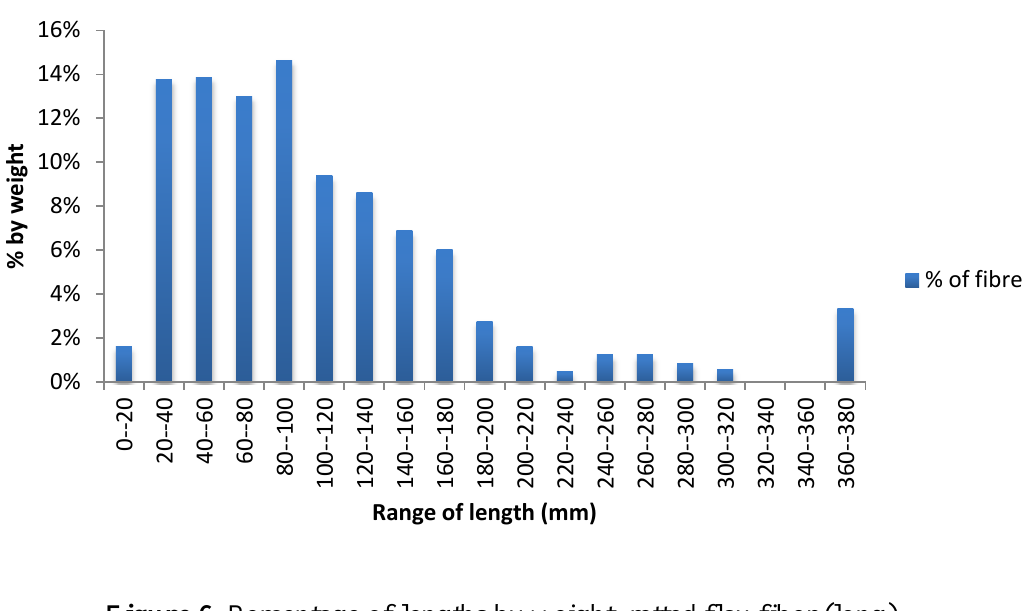
Figure 6. Percentage of lengths by weight–retted flax fiber (long).